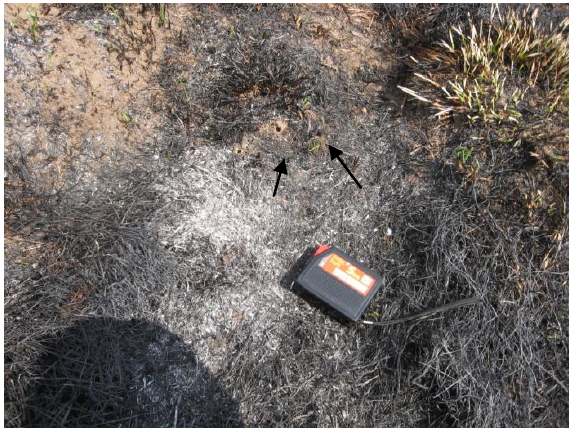
Fig. 11. Effects of ant mount build on ash (indicated with arrows) (re)distribution 16 days after the fire in the studied